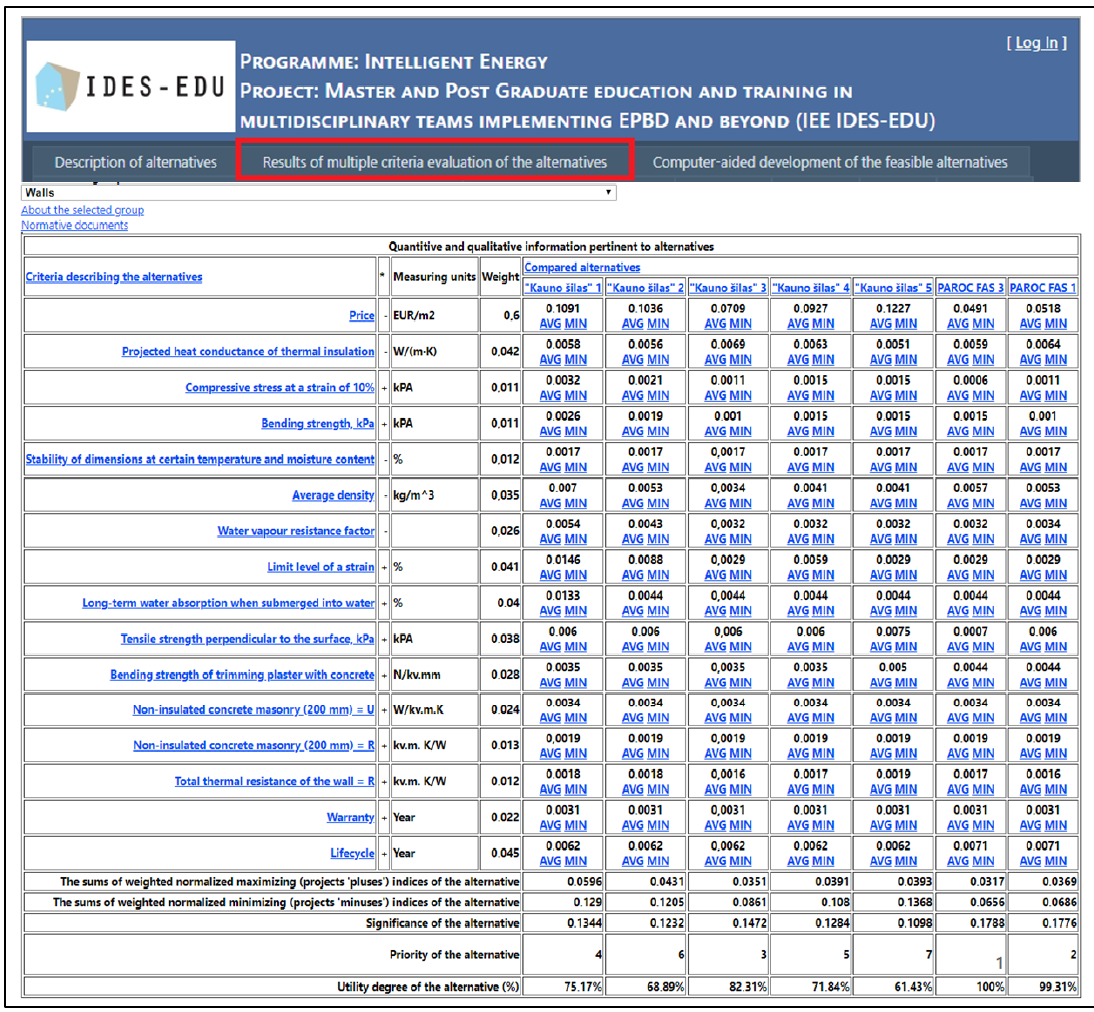
Figure 4. Multiple criteria evaluation of the insulation for walls. Energies 2018 , 11 , x FOR PEER REVIEW